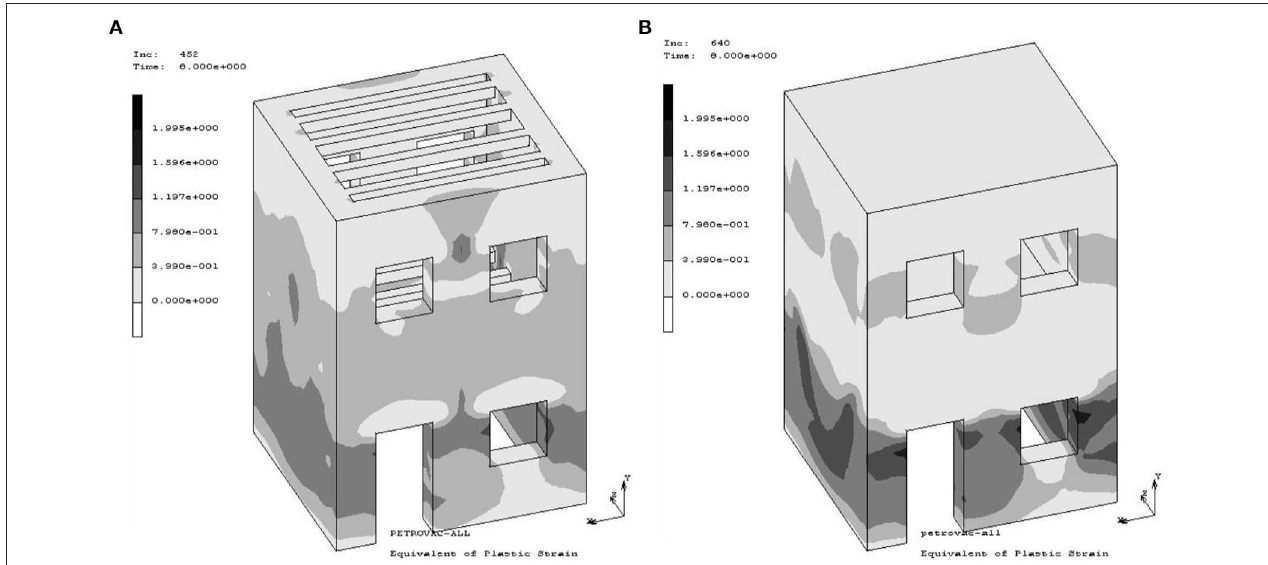
FIGURE 11 | Equivalent plastic strains at time 8s of the Petrovac record applying in the z direction (perpendicular face with openings) for models (A) M1 and (B) M2.